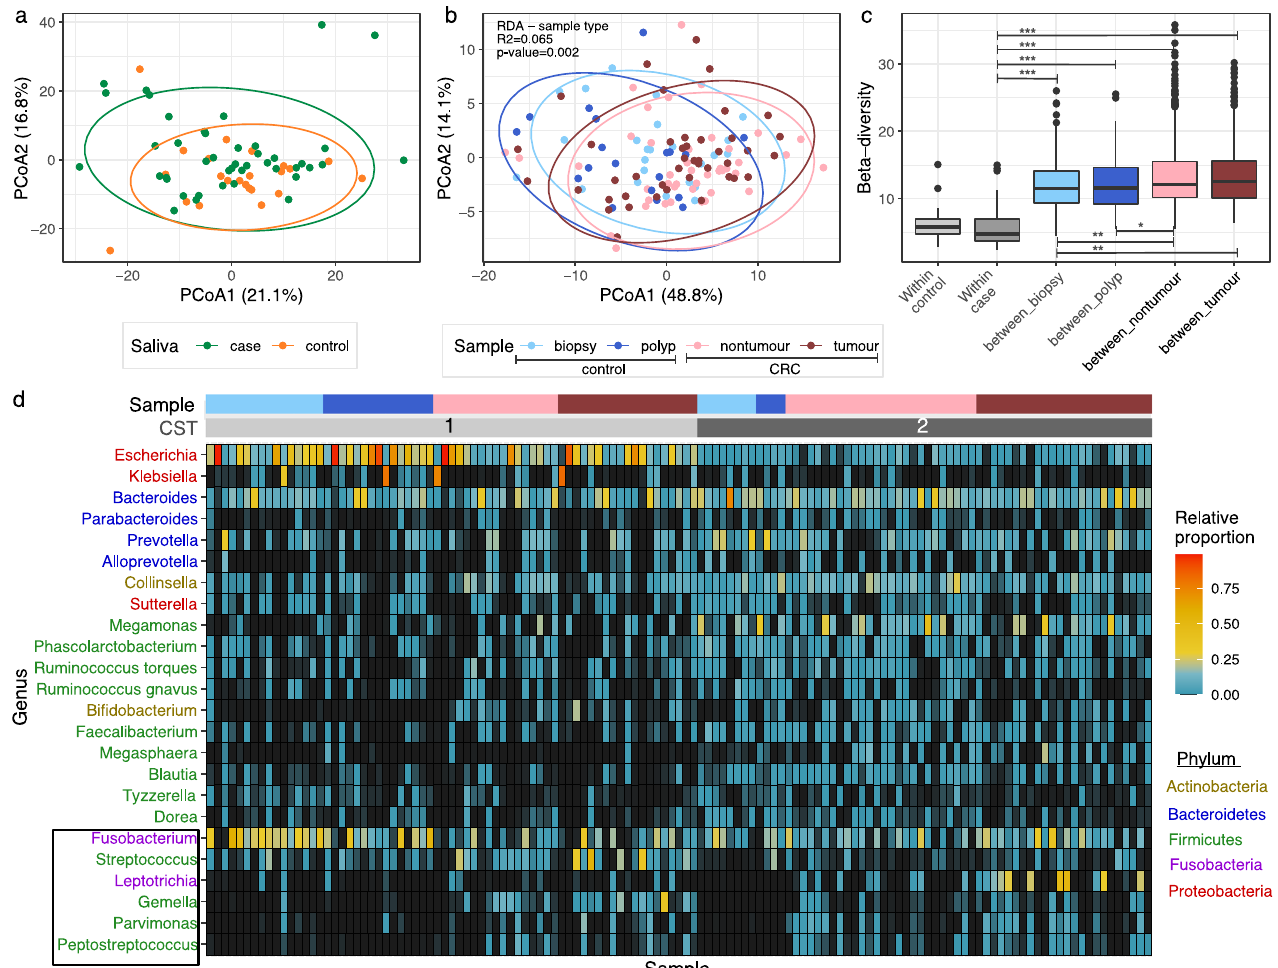
Fig. 1 The salivary and gut mucosal microbiomes of colorectal cancer patients. Principal coordinate analyses (PCoA), conducted on phylogenetic-assisted isometric log-ratio (PhILR) transformed data, of ( a ) 66 salivary microbiomes, and ( b ) 129 gut mucosal microbiomes, with different CRC groups and sample types denoted by different colours (see Keys; biopsies and polyps collected from controls, nontumours and tumours collected from cases). c Boxplot showing the distribution of pairwise beta-diversity, calculated on PhILR transformed values, observed in each gut microbiome category. Bold central lines denote the median, the upper whisker extends from the 75th percentile to the highest value within the 1.5*interquartile range (IQR) of the hinge, the lower whisker extends from the 25th percentile to the lowest value within 1.5*IQR of the hinge. Data points beyond the end of the whiskers are outliers. Asterisk markings represent statistically signi fi cant differences between groups, as calculated by posthoc Tukey test ( p -values ranging from >0.01 to ≤ 0.05 (*); from >1e − 5 to ≤ 0.01 (**); ≤ 1e − 5 (***)). d Heatmap displaying the proportional abundances of 24 most abundant genera (prevalence ≥ 15%, mean relative abundance ≥ 1%, and accounting for ~85% of the gut mucosal microbiome composition), with headers showing the samples ’ community state type (CST): CST1 (light gray), CST2 (dark gray), and the corresponding sample type: biopsy (light blue), polyp (dark blue), nontumour (pink), tumour (dark red). Genera were coloured according to their classi fi cations at Phylum level (see Keys). Genera in black box represent ones with probable origin from the oral cavity. The contributions of 24 genera listed here were summarized in Supplementary Table 3. Source data are provided as a Source Data fi